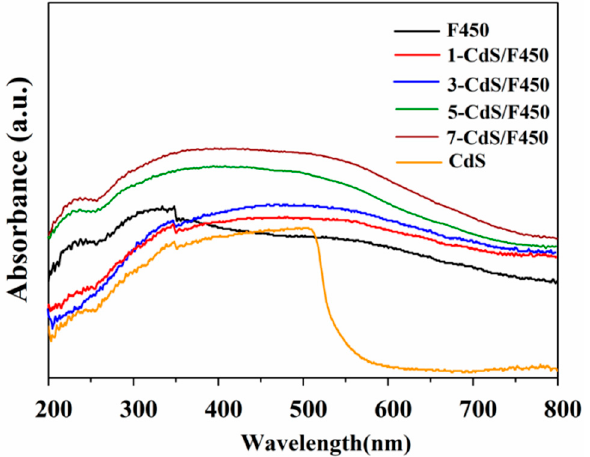
Figure 6. UV-vis adsorption spectra of all samples.